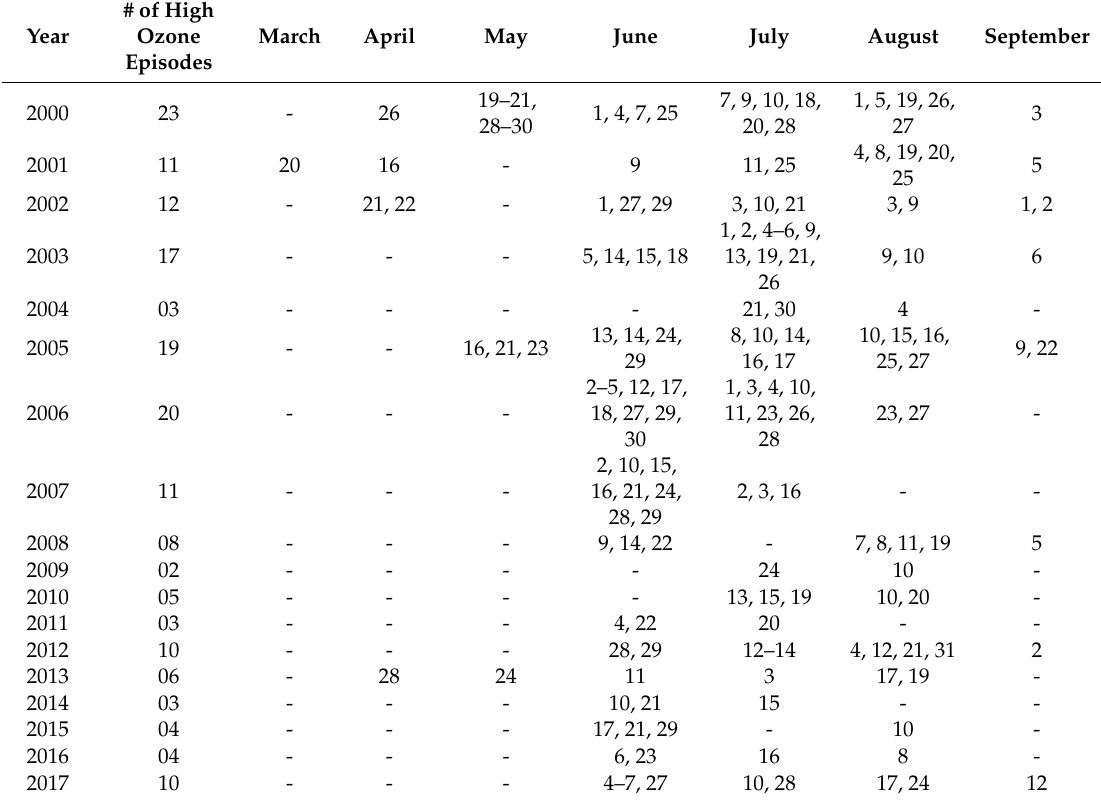
Table 2. The total number of annual high ozone episodes recorded at CAMS 12 (UTEP) and their monthly distribution as per the dates they